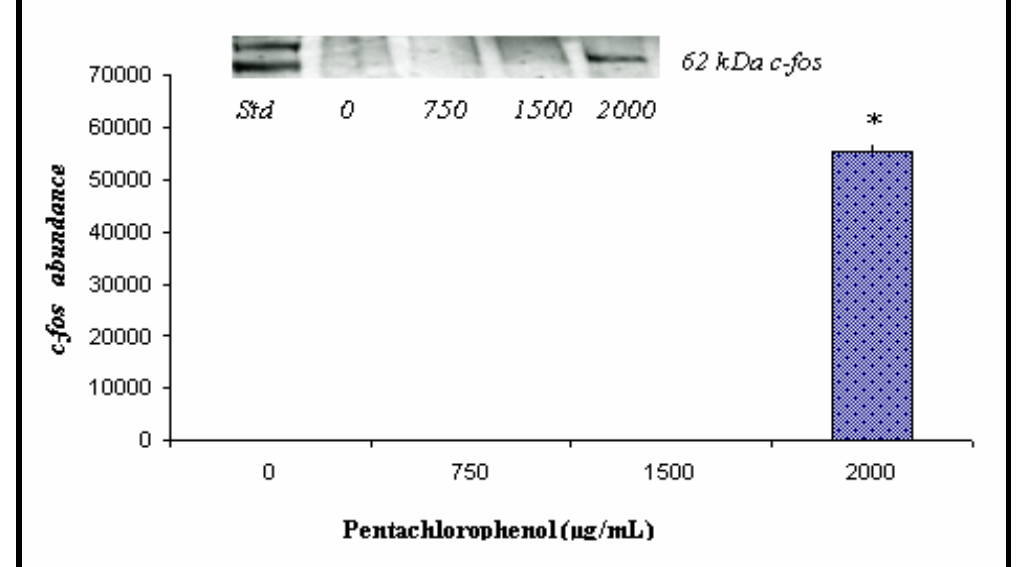
Figure 3: Western Blot for c-fos expression and densitometric analysis in PCP-treated channel catfish hepatocytes. Inset shows representative Western analysis. Densitometric analysis shows significant c-fos abundance at 2000 ug/mL. Bar represents c-fos abundance; values are means + SDs, n = 3. * Significantly different from control (0 µ g/mL PCP), p < 0.05 .